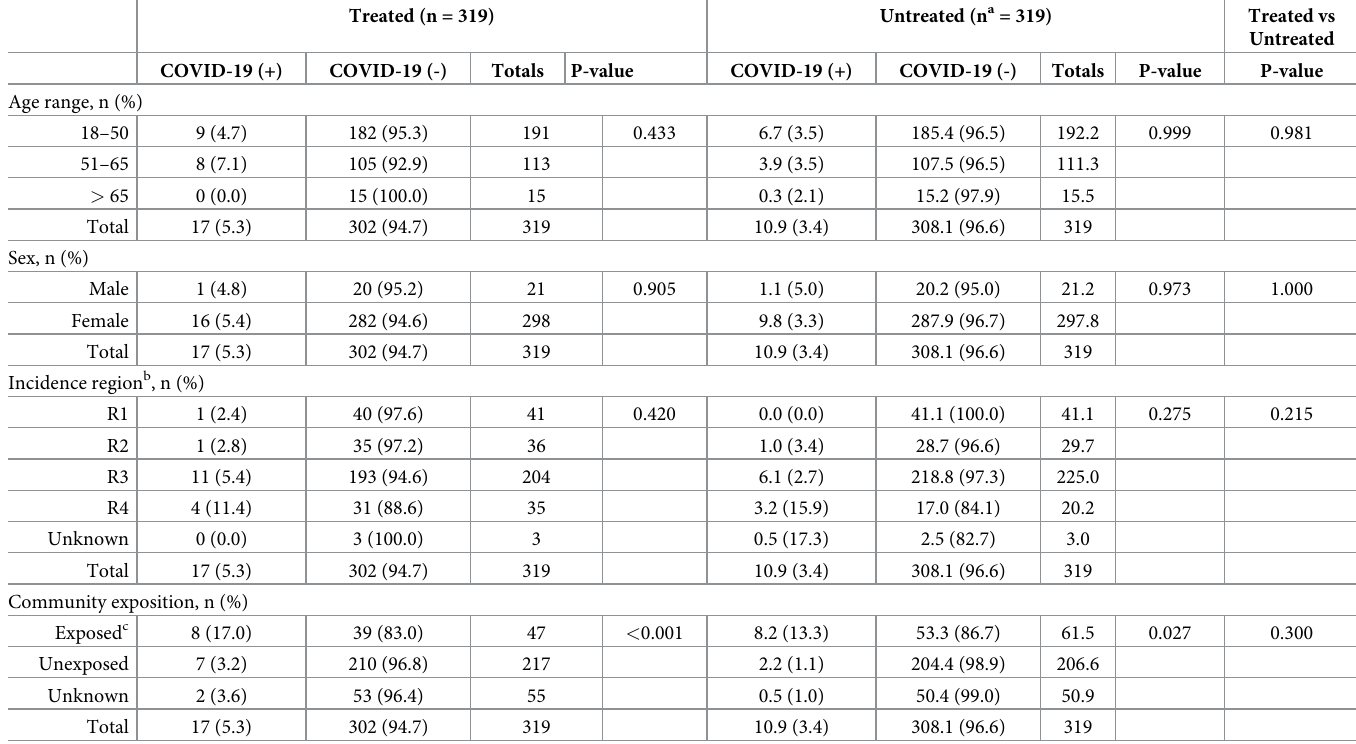
Table 1. Demographic characteristics of persons taking chloroquine or derivatives (treated) and matched control sample (untreated) according to their declared COVID-19 status. Treated (n = 319) Untreated (n a = 319) Treated vs